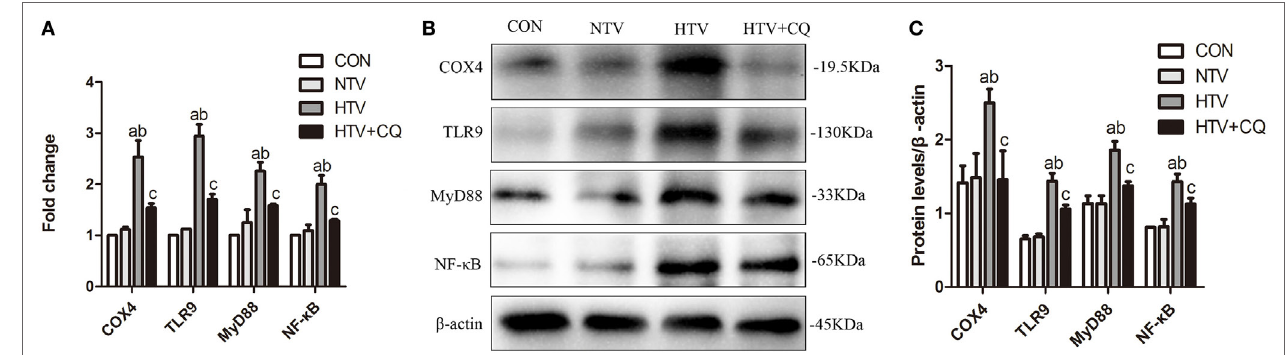
FigUre 4 | The mRNA and protein expression of cytochrome c oxidase 4 (COX4), toll-like receptor (TLR) 9, myeloid differentiation factor 88 (MyD88), and nuclear factor (NF)- κ B in lung tissues from spontaneous breathing group (CON group), normal tidal volume (NTV) group, high tidal volume (HTV) group, chloroquine (CQ) pretreatment upon HTV stimulation group (HTV + CQ). (a) Levels of COX4, TLR9, MyD88, and NF- κ B mRNA. (B) Levels of COX4, TLR9, MyD88, and NF- κ B protein by Western blot. (c) Relative expression of COX4, TLR9, MyD88, and NF- κ B protein. Fold expression for target genes was normalized to that measured for the β -actin gene. Both of these experiments were in triplicate. a P < 0.05 vs. CON group; b P < 0.05 vs. NTV group; and C P < 0.05 vs. HTV